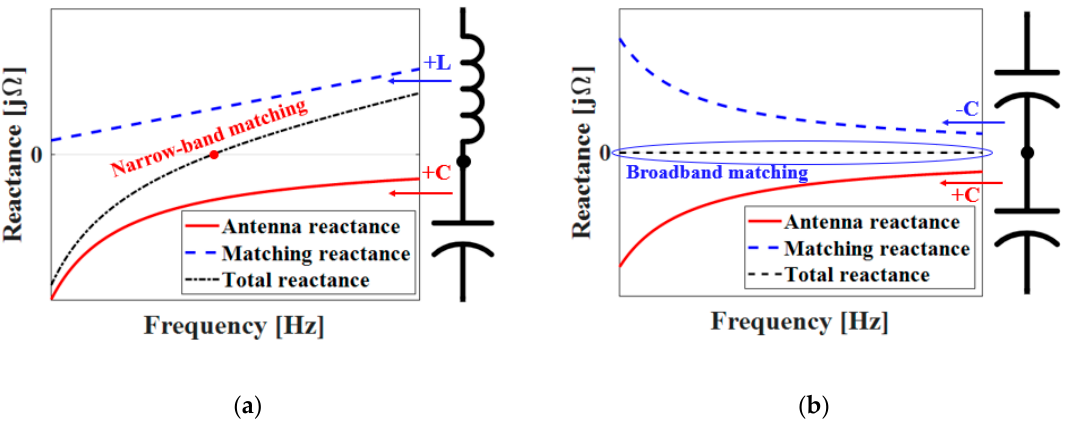
Figure 1. Antenna reactance cancellation using ( a ) passive components which follow the Foster’s reactance theorem. ( b ) Negative reactance generated by the non-Foster circuit matching technique.